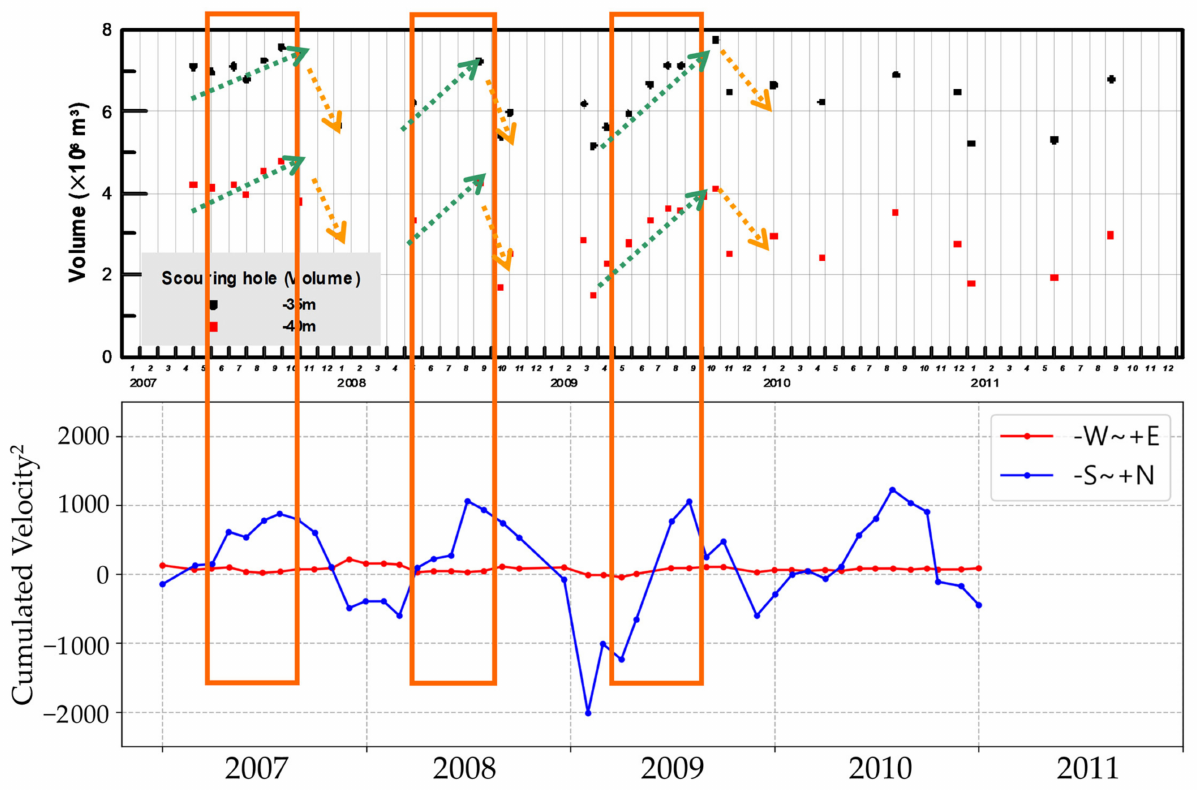
Figure 19. Scour volume and cumulative energy near the West Breakwater in 4 consecutive